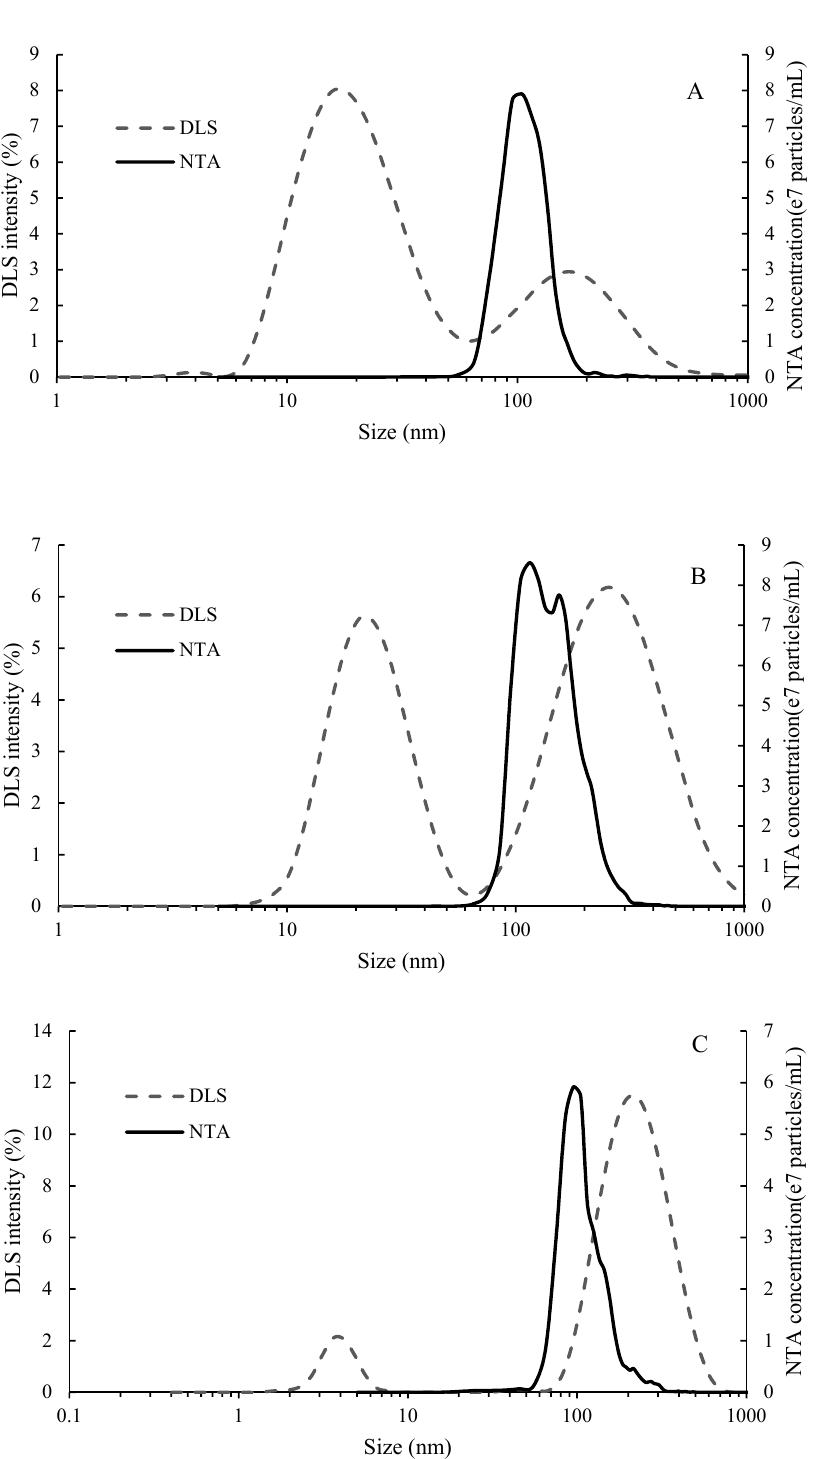
Figure 1. Particle size distribution of ( A ) MP, ( B ) AG and ( C ) ST, measured by dynamic light scattering (DLS) and nanoparticle tracking analysis (NTA).